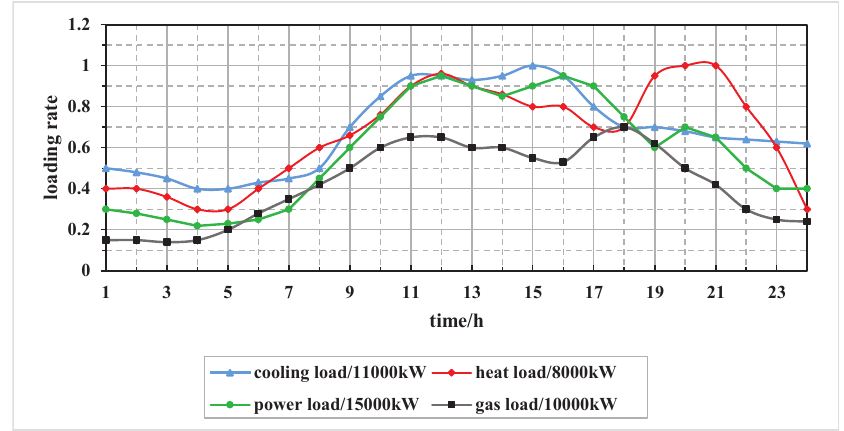
Figure 3. Hourly load status of gas, power, and heat and cooling load of MES.